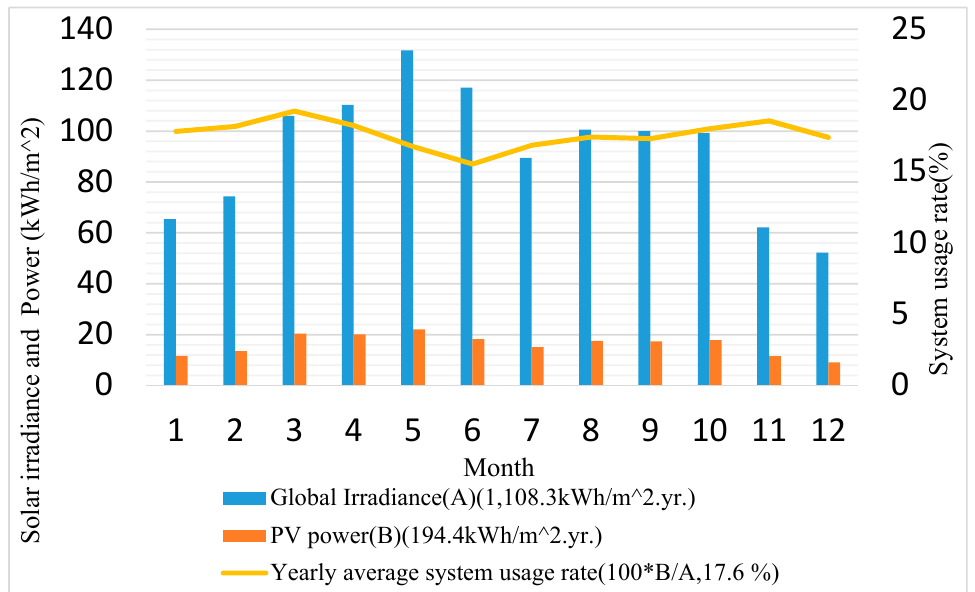
Yearly average system usage rate(100*B/A,17.6 %) Figure 11. The system usage rate of the bi-facial BIPV module under the PV angle 23.5°. The system usage rate of this PV system as a shade shows relatively uniform power distribution all year round independent of the solar altitude variation among the 12 months. The yearly average system usage rate is also relatively high for these reasons, corresponding to 17.6%. The increased power output caused by the uniform system usage rate (17.6%) of the bi-facial BIPV as a shade is 46% more than one by the low system usage rate (9.5%) of the wall attached bi-facial BIPV system, because bifacial PV cells can gener- ate electrical power, not only through the front but also through the rear, coming from the wall surface, window, and surroundings, etc. These results are described as the ESR in Table 1. The global irradiance (105 kWh/m 2 ) in March is less than that (117 kWh/m 2 ) in June. Global irradiance/ESR (468.6 kWh/m 2 ) in June is 0.25. Global irradiance/ESR (300.6 kWh/m 2 ) in March is 0.35. Therefore, the system usage rate of March is slightly higher than that of June. A similar outcome as March is also shown in November. This kind of BIPV system as a shade can be very well combined with a bi-facial PV cell rather than a mono facial solar cell. As reflected light and scattered light reach the rear and the front of the bi-facial solar cell, the module contributes to the power generation output, and the daily power at the same time as the instantaneous maximum power value increases. This is why most of the increase in the total solar radiation incident on the front and back of the bifacial solar cell module compared to the mono facial PV cell shows the output char- acteristics reflected by an increase in current. These results demonstrate the effective solar irradiance (ESR), consideration for power generation improvement, and continuity of ESR in Table 1.